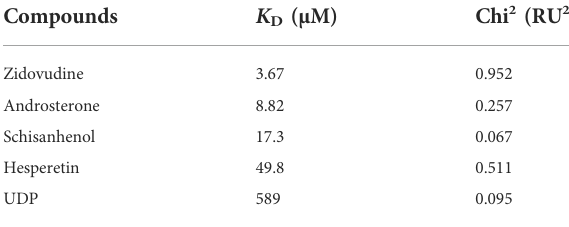
TABLE 2 Calculated K D and Chi 2 for compounds binding to